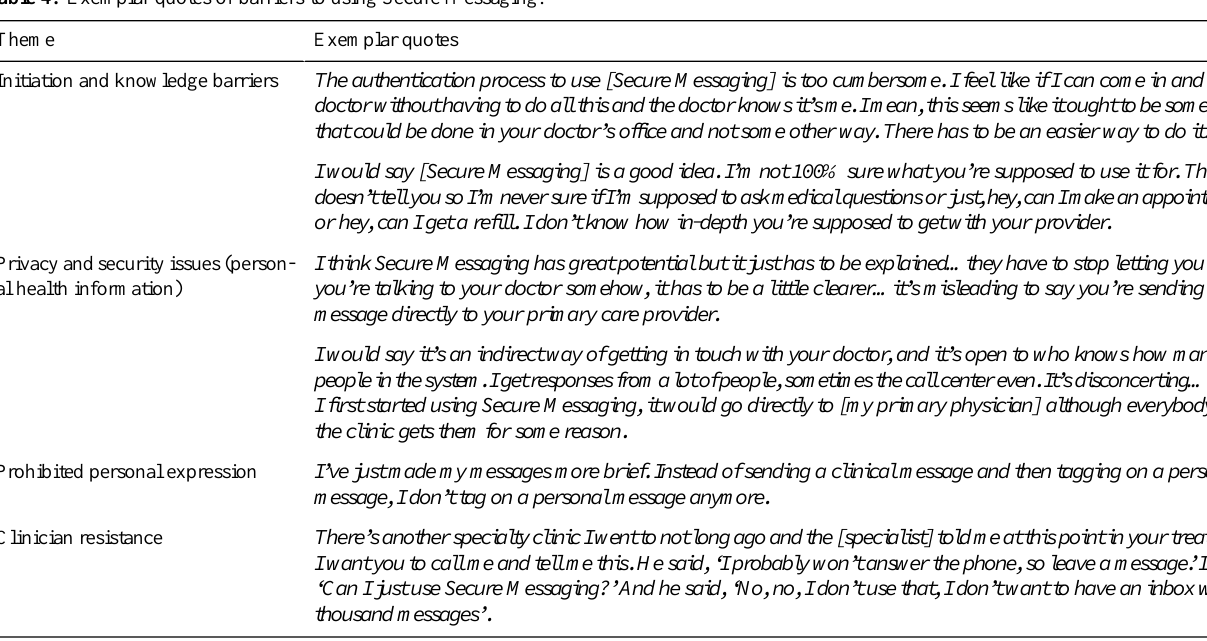
Table 4. Exemplar quotes of barriers to using Secure Messaging.